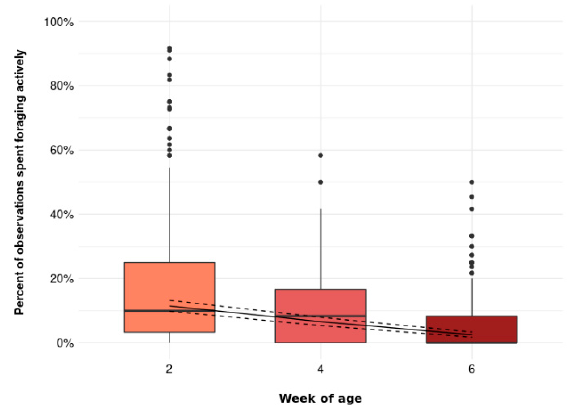
Figure 4. The percentage of observations spent foraging actively at 2, 4, and 6 weeks of age ( p = 0.001). Boxplots show medians, lower, and upper interquartile range of raw data. Whiskers indicate 1.5 times the interquartile range. Solid lines represent estimated means and dashed lines represent 95% confidence intervals.